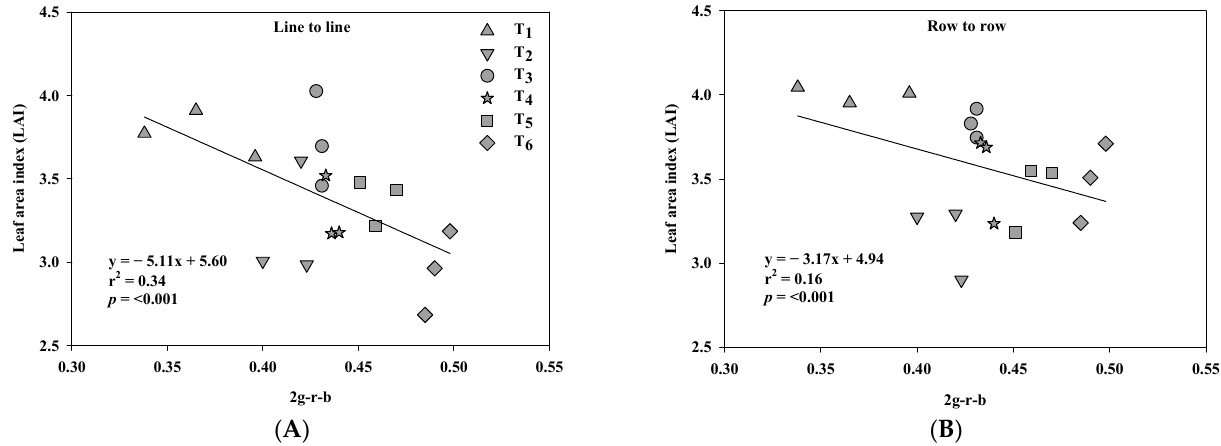
Figure 7. Relationship between 2 g-r-b and LAI, measured between the lines (panel ( A )) and between rows (panel ( B )). The PAR was measured by taking reading in between lines (panel ( A )) and in between rows (panel ( B )) since canopy coverage was different due to spacing (line to line = 60 cm and plant to plant = 20 cm for maize) of the crops.